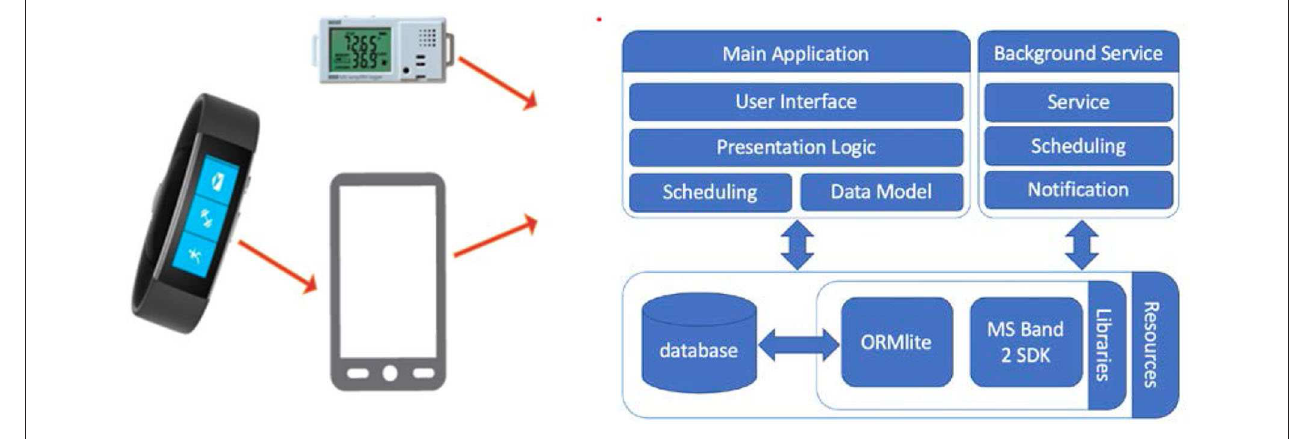
FIGURE 3 | Mobile application architecture.